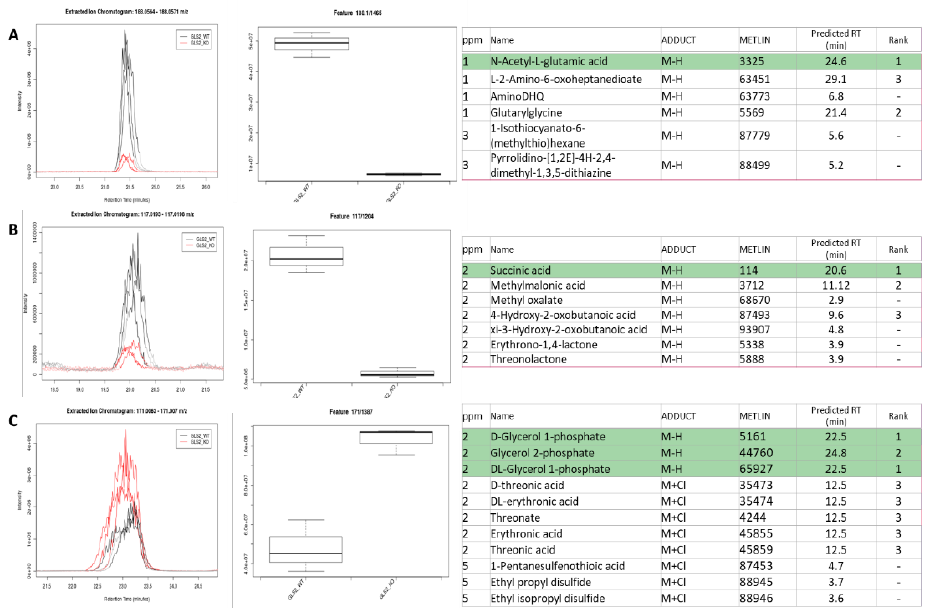
Figure 5. Application of the MPNN model to predict the identities of features altered by GLS2 KO in primary mouse hepatocytes, p < 0.01, fold change >2, signal intensity >1E6. ( A – C ) represent the most significantly altered features’ extracted ion chromatograms (EICs), box plots, and putative identities as deduced using XCMS.